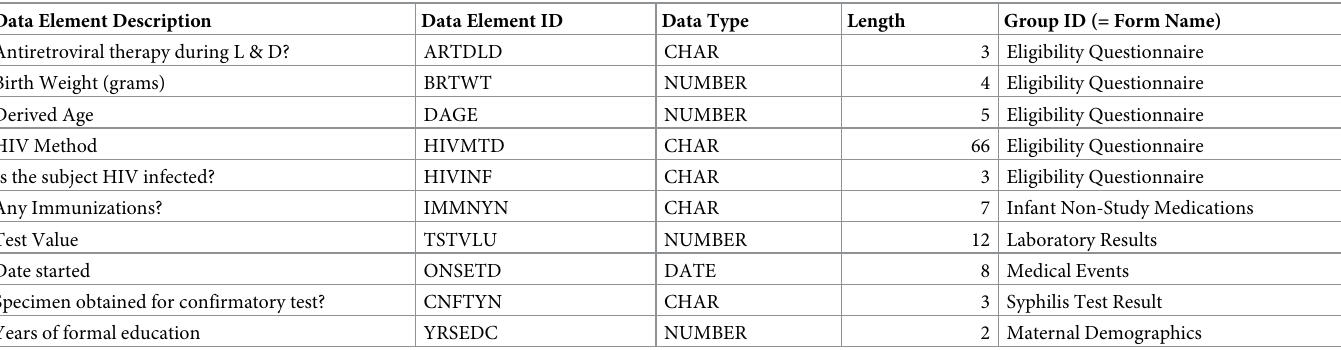
Table 1. Example data elements (for trial NCT00099359: ‘Trial of Three Neonatal Antiretroviral Regimens for Prevention of Intrapartum HIV Transmission’). Data Element